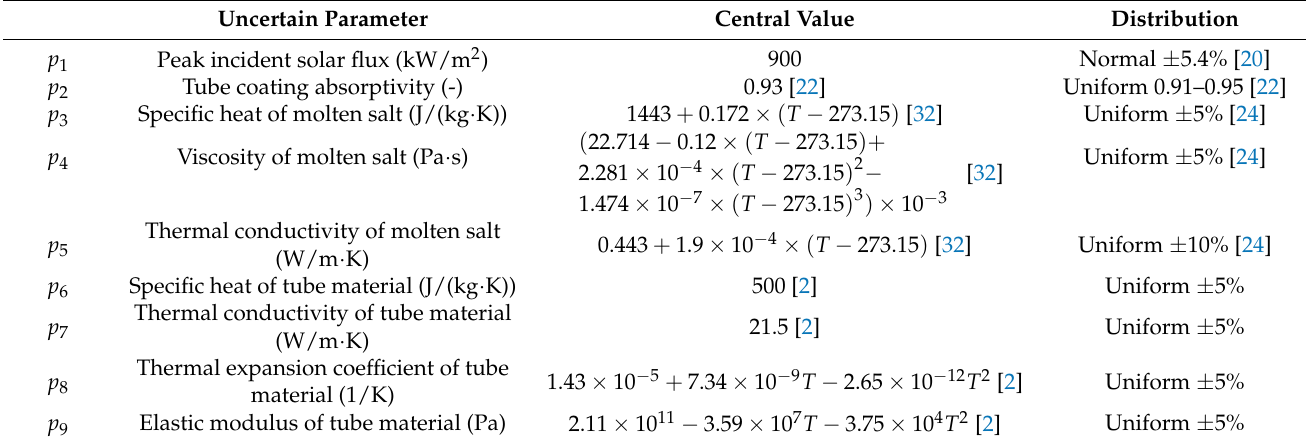
Table 1. Central values and uncertainty probability distributions of input